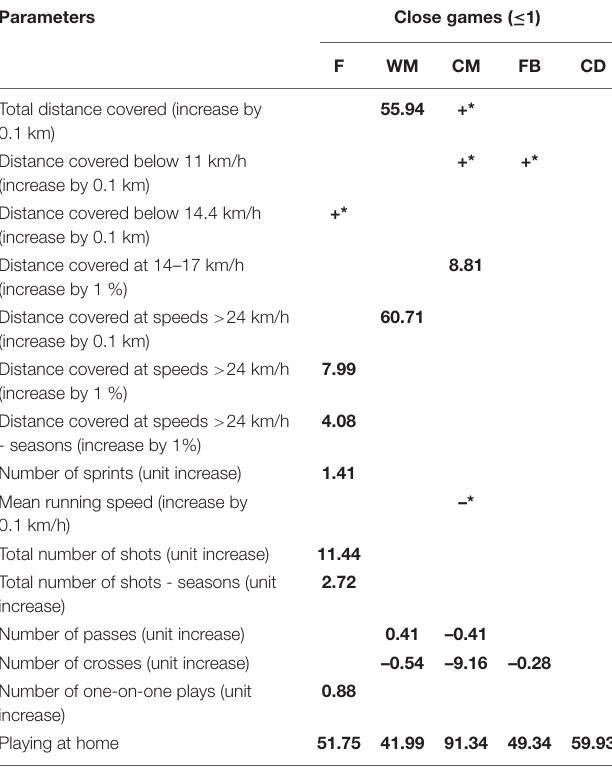
TABLE 2 | Relationships between selected variables and match outcomes among elite German soccer players.